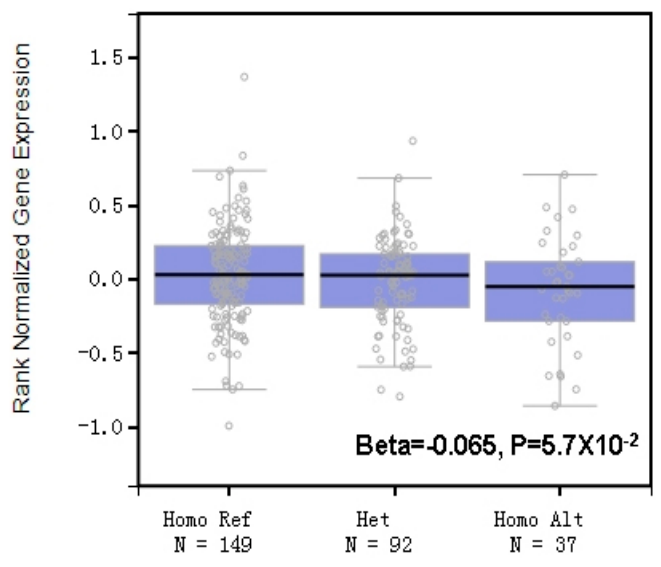
Figure 1. The expression quantitative trait loci (eQTL) analysis of rs2290846 in GTEx.